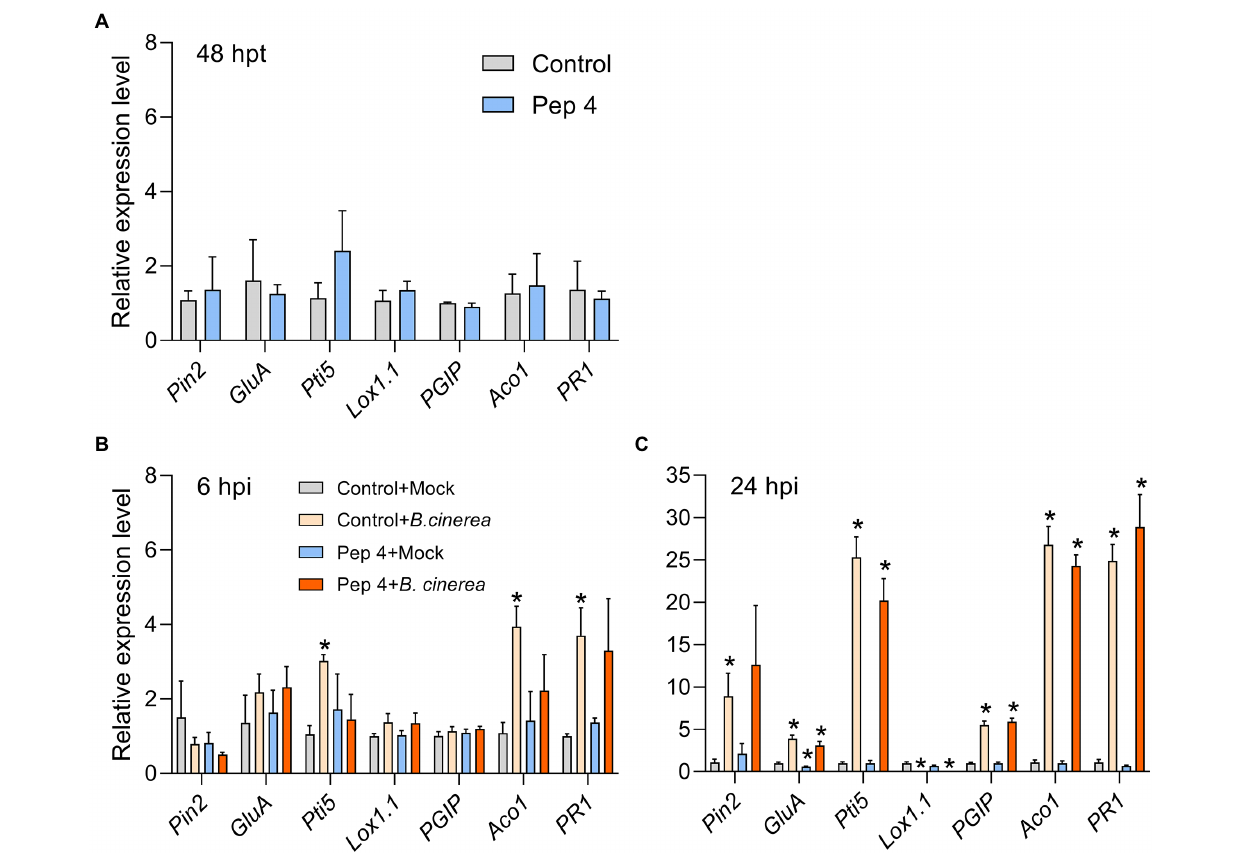
FIGURE 7 | Expression of defense genes in Solanum lycopersicum cv. Micro-Tom plants treated with Pep 4 (A) and subsequently infected with Botrytis cinerea (B,C) . Peptide treatments were performed by spraying 50 μ M Pep 4 in water containing 0.01% v/v Silwet L-77 AG. Pathogen inoculations were performed by spraying a conidial suspension of B. cinerea . Hpt, hours post treatment; hpi, hours post infection. Control, water containing 0.01% v/v Silwet L-77 AG. Mock inoculations were performed by spraying the fungal culture medium potato dextrose broth. Genes analyzed: 1-aminocyclopropane-1-carboxylate oxidase 1 ( ACO1 ), Lipoxygenase A ( Lox1.1 ), Pathogenesis-related protein 1 (PR1), Pathogenesis-related genes transcriptional activator 5 ( PTI5 ), Polygalacturonase inhibitor protein ( PGIP ), Proteinase inhibitor II ( PIN2 ), and Beta-1,3-glucanase A ( GluA ) . Actin-7 was used as the endogenous reference gene for normalization. Control (A) or control + mock (B,C) were used as the calibrator sample (grey bars) for calculations. Average fold change values from three biological replicates (different plants) and two technical replicates ±SEM are shown. Statistical analysis was performed by t -test by comparing to the calibrator sample. Significant differences are marked by asterisk ( p <